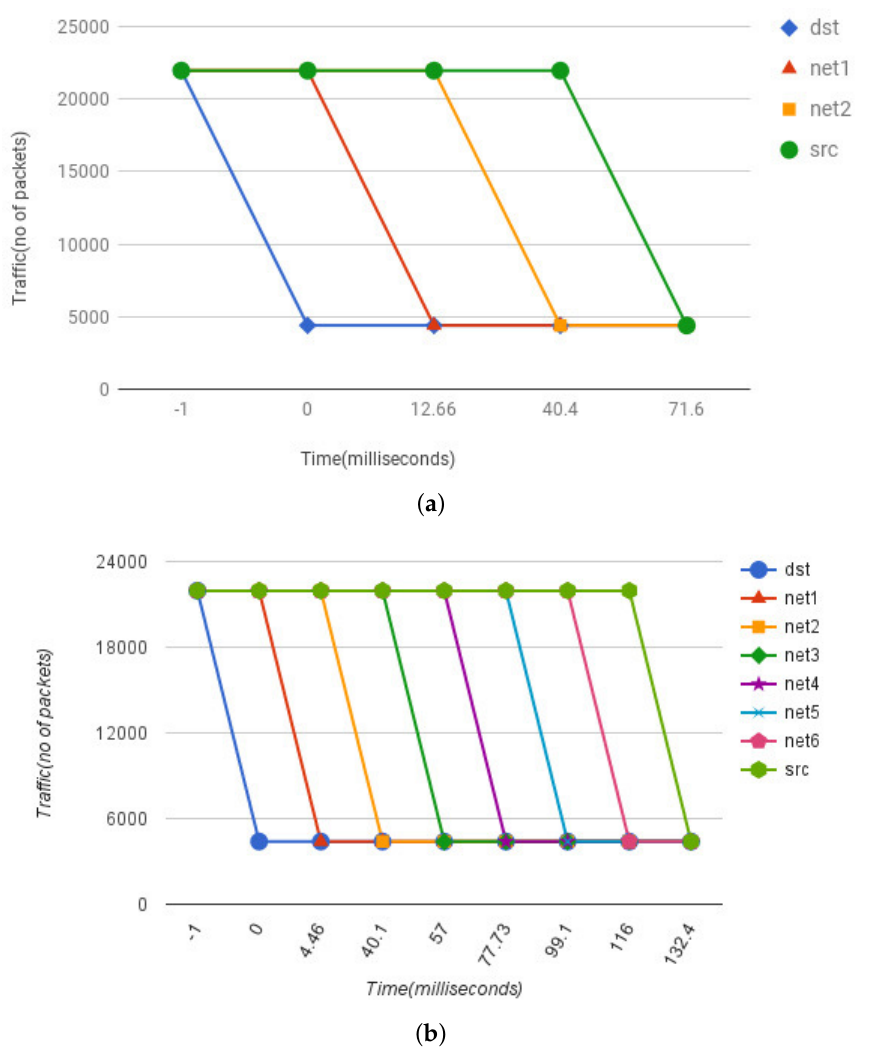
Figure 7. Mitigation Effect in LAN Setting: Shows the data flowing from source to destination and the time it takes to mitigate the attack. ( a ) Two Intermediate Networks; ( b ) Six Intermediate